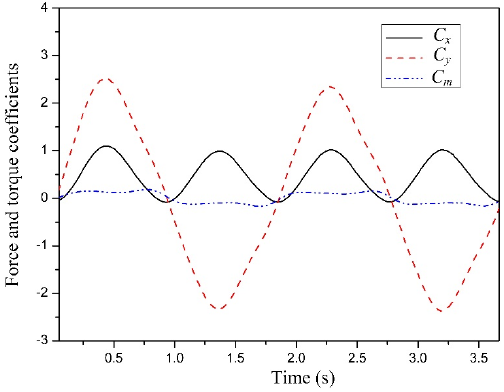
Figure 5. Performance curves of flapping foil.